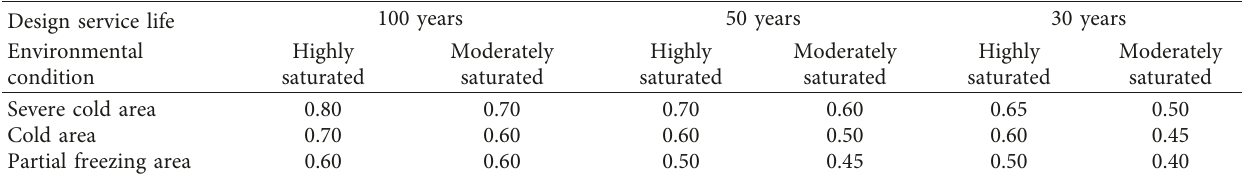
Table 4: Specified minimum value of the DF .